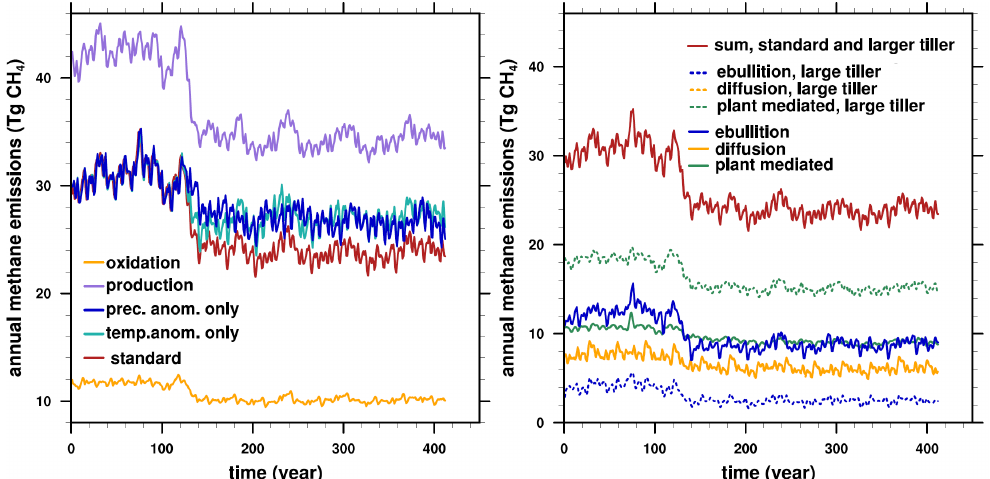
Fig. 8. (a) Total annual methane emission from northern peatlands in the standard scenario (red) compared to factorial runs where only changes in temperature (cyan) or only in precipitation (blue) were taken in account. The total annual methane production rate (violet) and soil oxidation rate (yellow) is plotted as well for the standard scenario. (b) Contribution of the three different transport pathways to the total emissions. Results are obtained with the best fitting parameters (solid lines) and a run with a doubled tiller-radius (dashed lines). The total emissions and emissions by diffusion are identical for the standard run and the doubled tiller-radius run, whereas there is a redistribution of plant-mediated emissions and emissions by ebullition. Climate forcing data are from ensemble simulation s1 and model output is smoothed with a